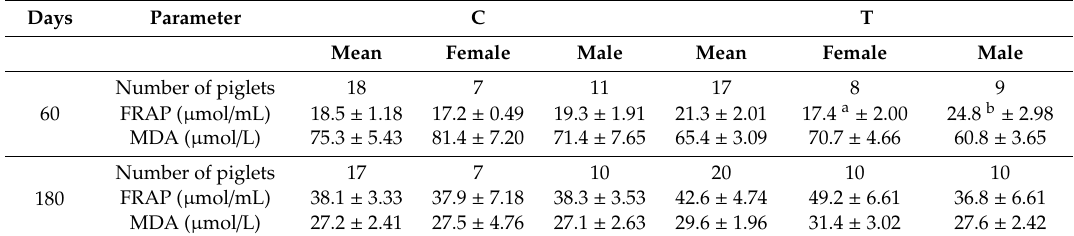
Table 2. Mean plasma concentrations ( ± S.E.M.) for total ferric antioxidant capacity (FRAP) and lipid peroxidation (malondialdehyde; MDA) in pigs born from sows treated or not with hydroxytyrosol and linseed oil during pregnancy (groups T and C, respectively) at 60 and 180